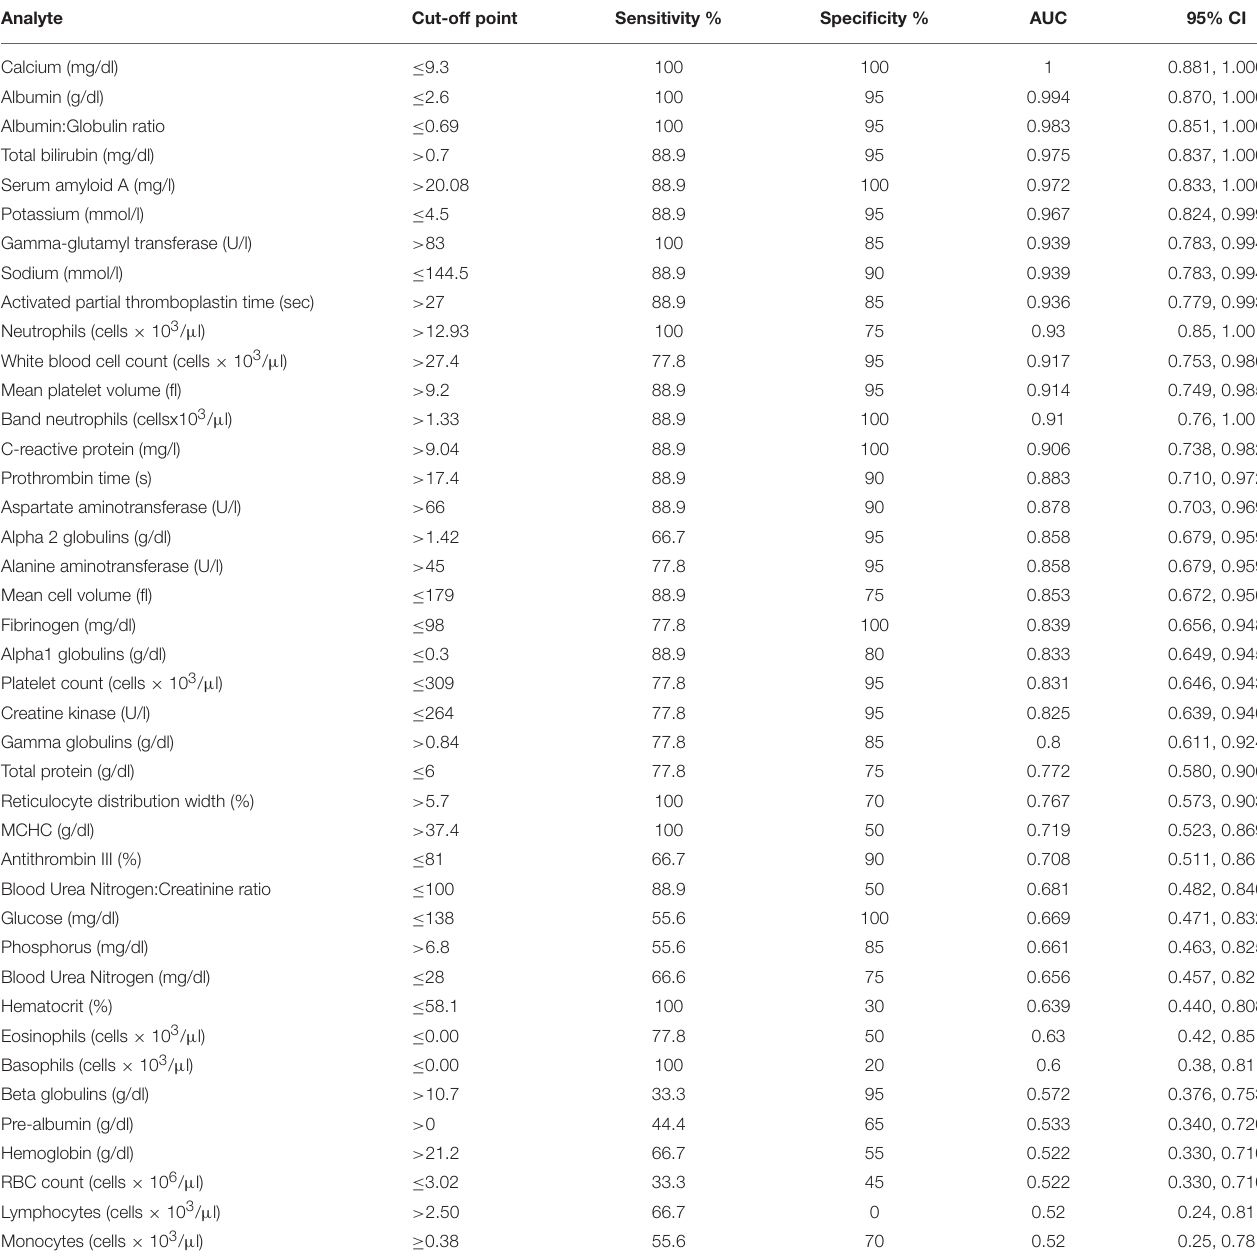
TABLE 1 | Cut-off points, sensitivity, specificity, area under the curve (AUC), and 95% confidence interval (CI) from highest to lowest AUC in the diagnosis of Otostrongylus circumlitis clinical infection in Northern elephant seals ( Mirounga angustirostris ). Analyte Cut-off